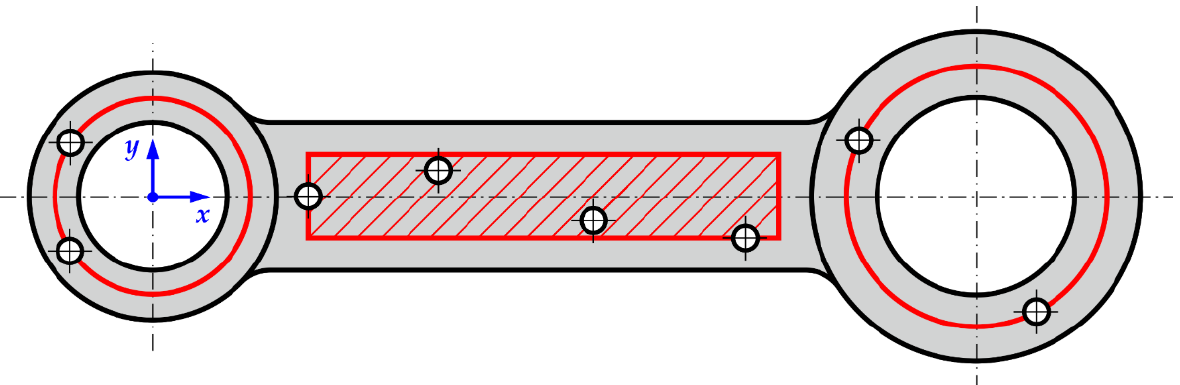
Figure 3. Defect domains with regard to the position of a through-hole defect in a connecting rod (the multiple sketched through-holes serve for illustration, only a single defect per part can occur).